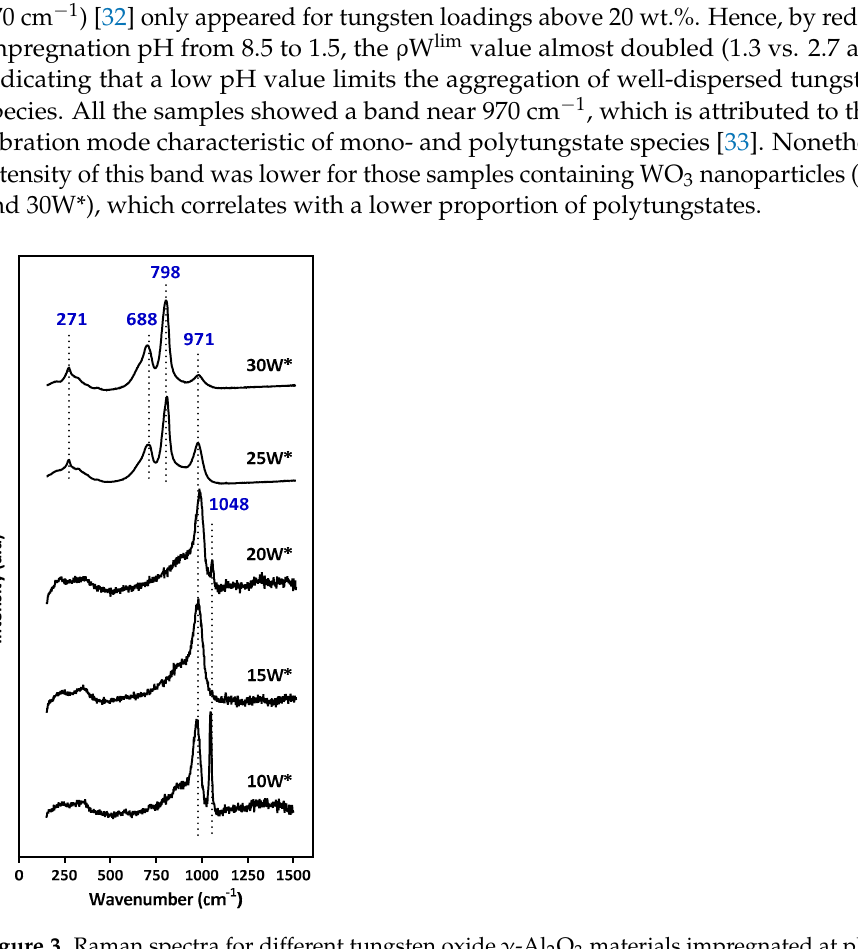
Figure 3. Raman spectra for different tungsten oxide γ -Al 2 O 3 materials impregnated at pH 1.4. The * symbol refers to the pH value of 1.5 during tungsten impregnation.